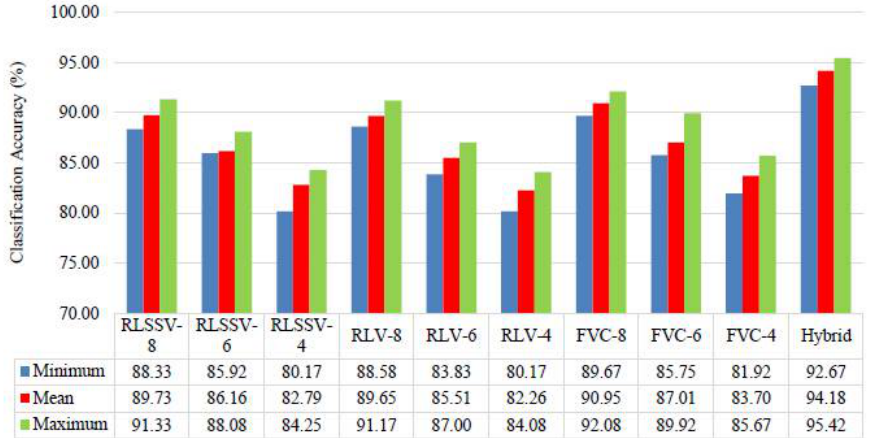
Figure 4. Classification accuracy of PNN networks with IAQ datasets [33].